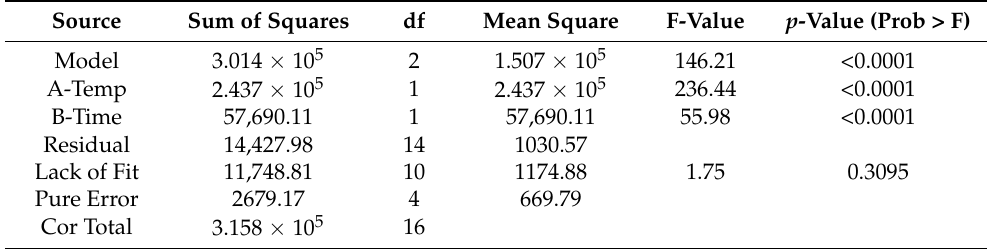
Table 2. Analysis of variance (ANOVA) of the generated RSM model to represent the effect of [Ch][OAc] pretreatment on sugar yield.